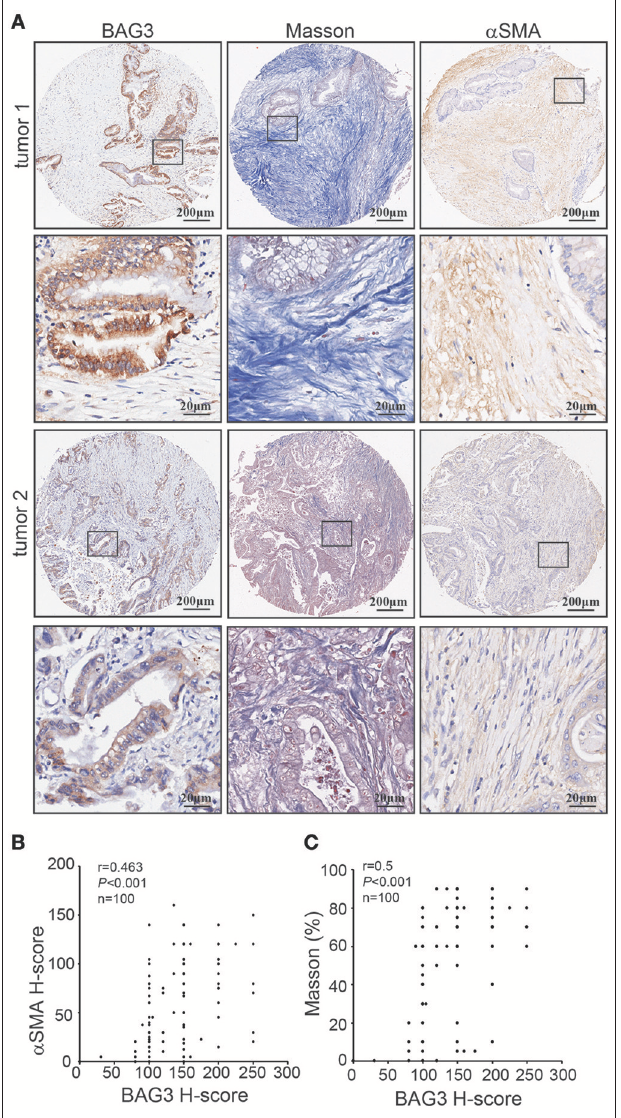
FIGURE 2 | Correlation of BAG3 and fibrosis in pancreatic cancer tissues. (A) Representative immunohistochemistry staining with BAG3, α SMA, as well as Masson staining in pancreatic cancer tissues. (B,C) Scatter plots showing the positive correlation between BAG3 and α SMA (B) or Masson (C) IHC score in pancreatic cancer tissues. Pearson’s coefficient tests were performed to assess statistical significance.